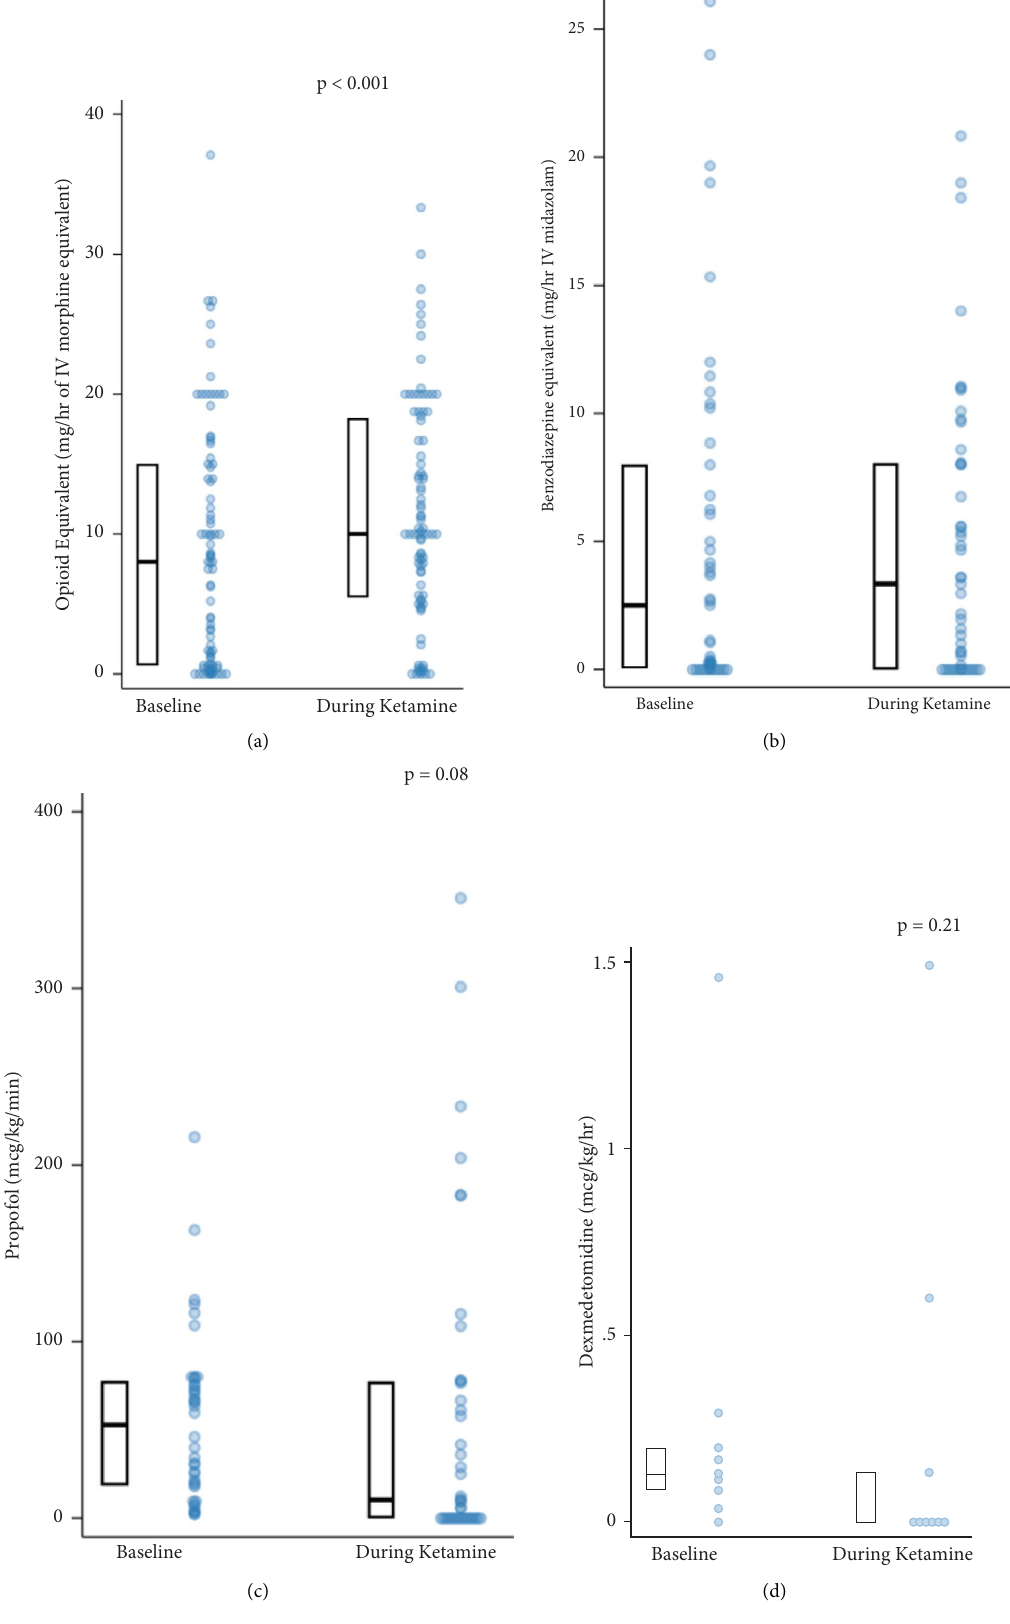
Figure 2: Doses of select sedative and analgesic drugs administered at baseline and during ketamine use. Te four panels show opioids (a), benzodiazepines (b), propofol (c), and dexmedetomidine (d). Te Wilcoxon signed rank test was used to compare median dose values of these drugs at baseline and during ketamine and generated P values are